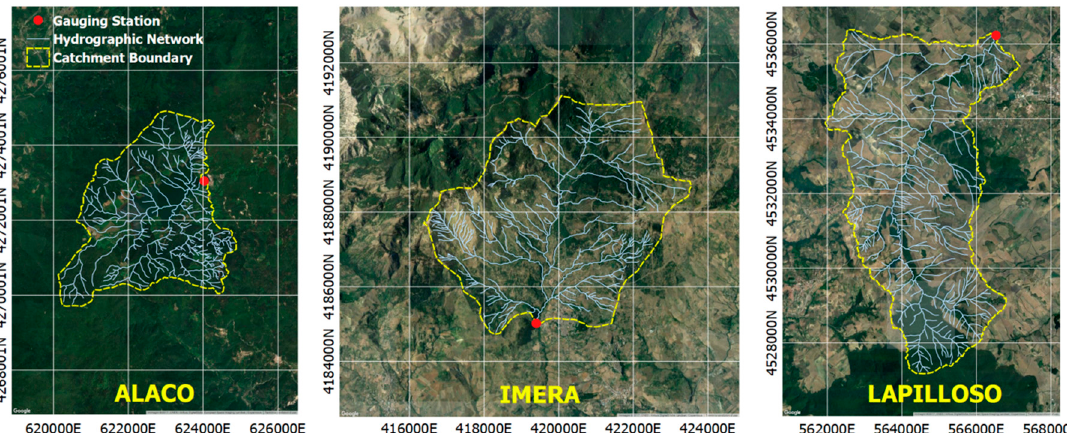
Figure 6. Catchment boundaries, hydrographic networks, and locations of gauging stations.